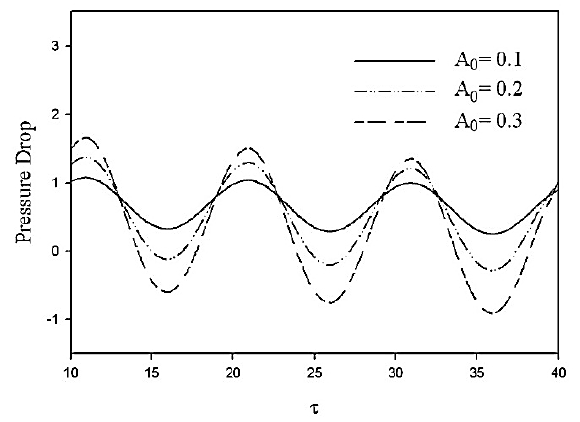
Fig. 12. Temporal variation of pressure drop for different amplitude of pulsation at Re=100, 0.02 φ = and